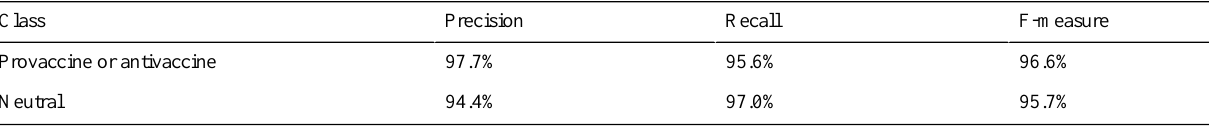
Table 4. Precision, recall, and F-measure for the binary